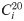
(a) Distribution of the distances of individual papers to the centers of their nearest clusters in the years 1981 (blue), 1991 (red), and 2011 (green). Over time, the distribution shifts toward smaller distances, i.e. more papers tend to appear in cluster centers. (b) The distribution of degrees over the same years shift towards much larger values (tail increases), i.e. there is a tendency to increasingly link to more similar papers. (c) Scatterplot of citations of papers published in 1991, twenty years after their publication, Ci20, versus their distance to cluster centers. The 90%, 70%, and 50% quantiles are shown in green, red, and blue, respectively. Citations increase with higher distances from clusters; bridging papers are awarded in the long run. (d) Citations, Ci20, versus their degree. A clear increase is apparent. (e) Distribution of citations for small and large values of distance. The plot is a normalized histogram of the 400 papers with the shortest distances. The blue distribution is for the 400 papers with the largest distance. (f) Distribution of citations for small and large degree.